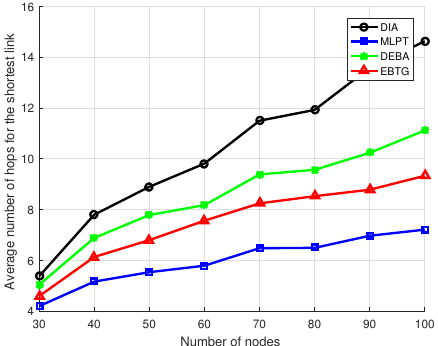
Figure 6. Average number of hops for the shortest link.